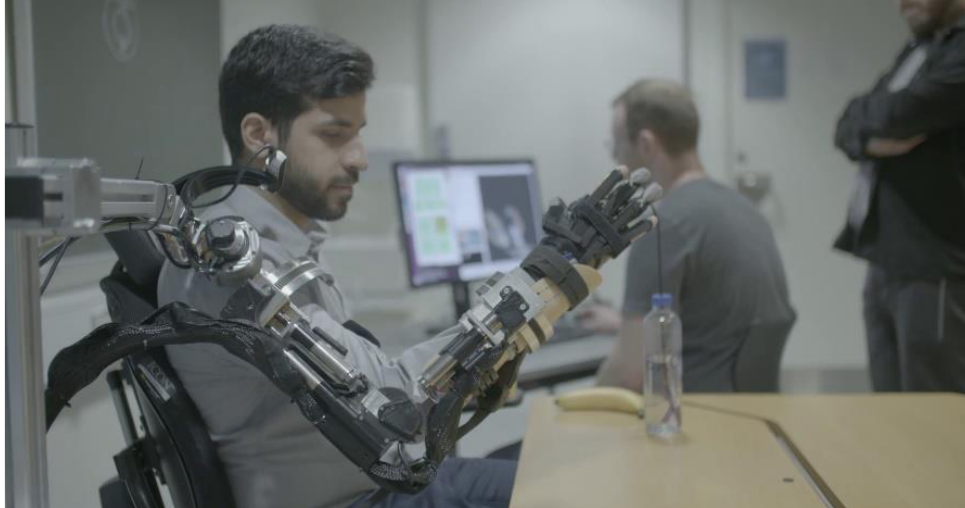
Figure 2. The EXOTIC exoskeleton system. An individual commands the EXOTIC exoskeleton using a tongue interface shared with computer vision-based semi-automation. The individual shown in the image has given written consent to the use of the image.